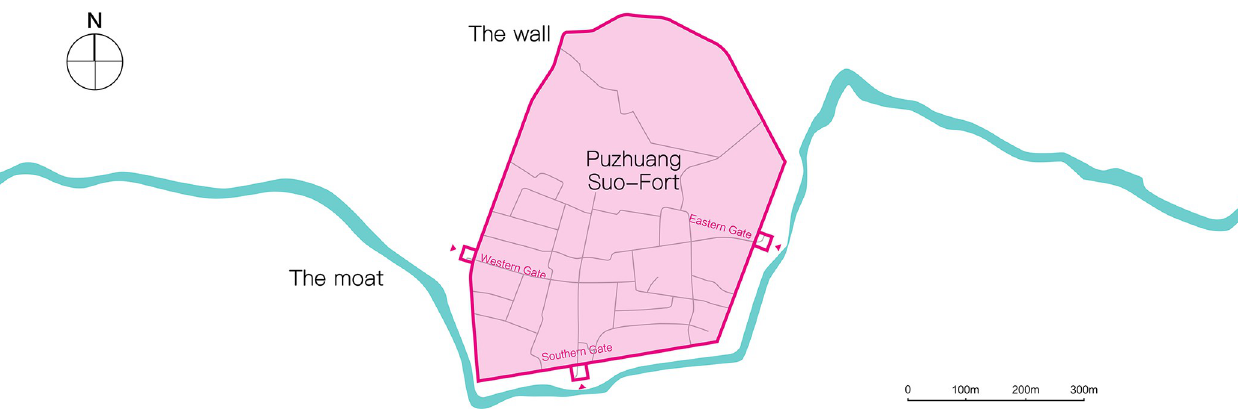
PLOS ONE | https://doi.org/10.1371/journal.pone.0282537 March 2, 2023 4 /